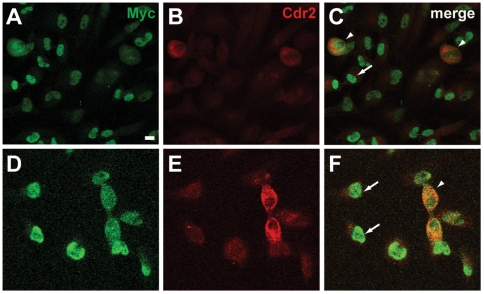
Cdr2 colocalizes with c-myc during mitosis.Low power (20X), thin section confocal images of HeLa cells stained with anti-c-myc (9402; A, D), anti-Cdr2 (4F5; B, E) and merged images (C, F). Arrows denote nuclear localized c-myc; arrowhead indicates mitotic cells with co-localized c-myc and cdr2. Scale bar = 20 µm.